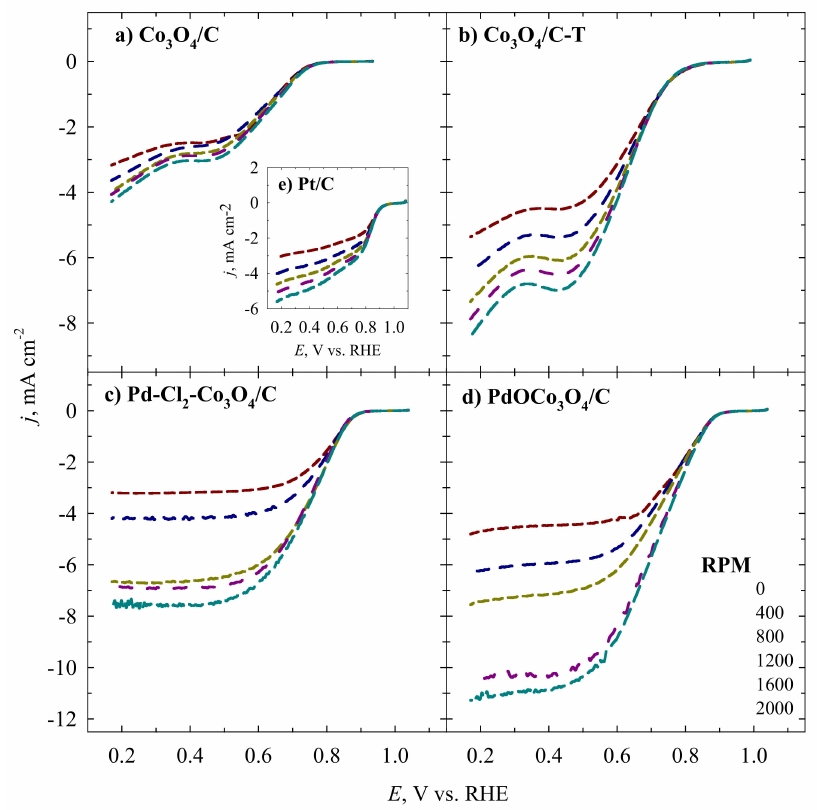
Figure 6. Linear sweep voltammetry curves for O 2 reduction on the Co 3 O 4 /C ( a ), Co 3 O 4 /C-T ( b ), Pd-Cl 2 -Co 3 O 4 /C ( c ), PdOCo 3 O 4 /C ( d ), catalysts in the O 2 -saturated 0.1 M NaOH solution at 5 mV s − 1